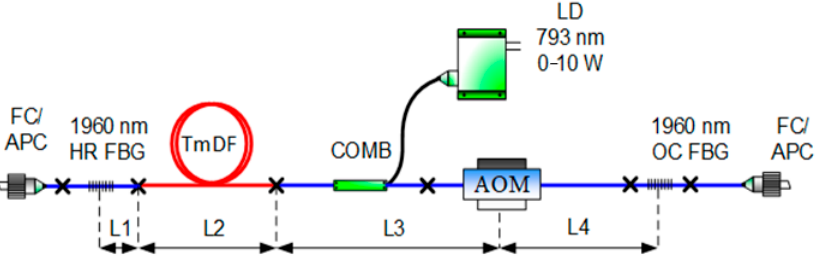
Figure 1. Optical scheme of the thulium-doped fiber laser. FC/APC—optical connector with an angled polish; L1,3,4—passive fiber lengths; L2—active fiber length.